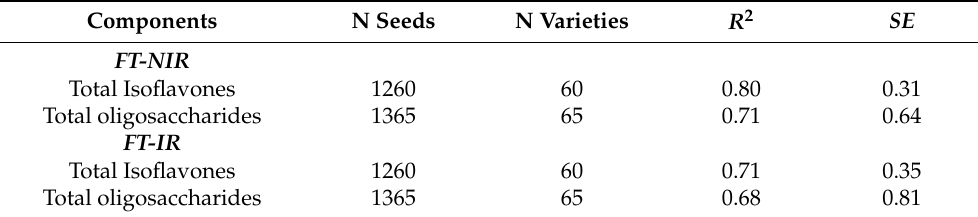
Table 5. The statistical result of the testing model for predicting isoflavones and oligosaccharides in soybean